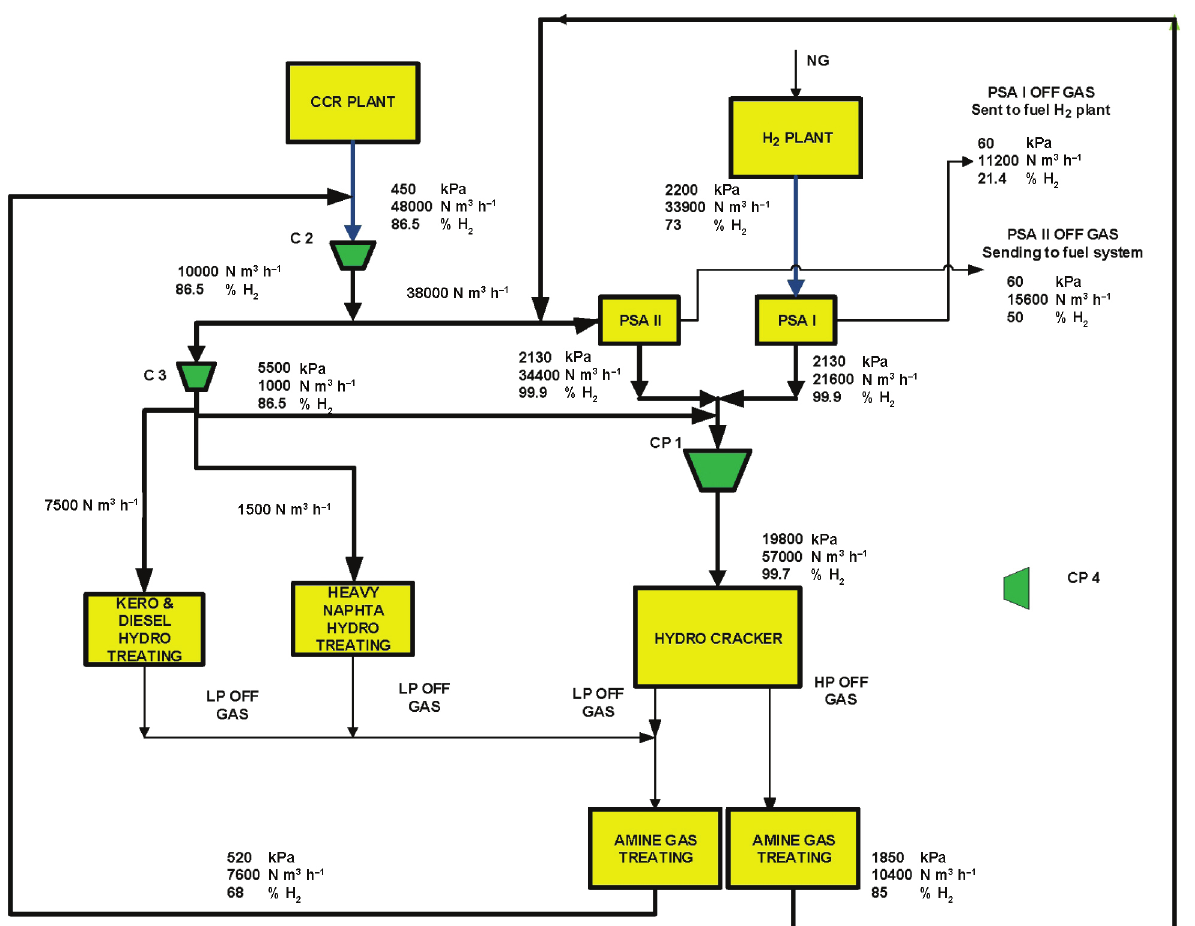
Fig. 4 – Optimum network design for Case 2